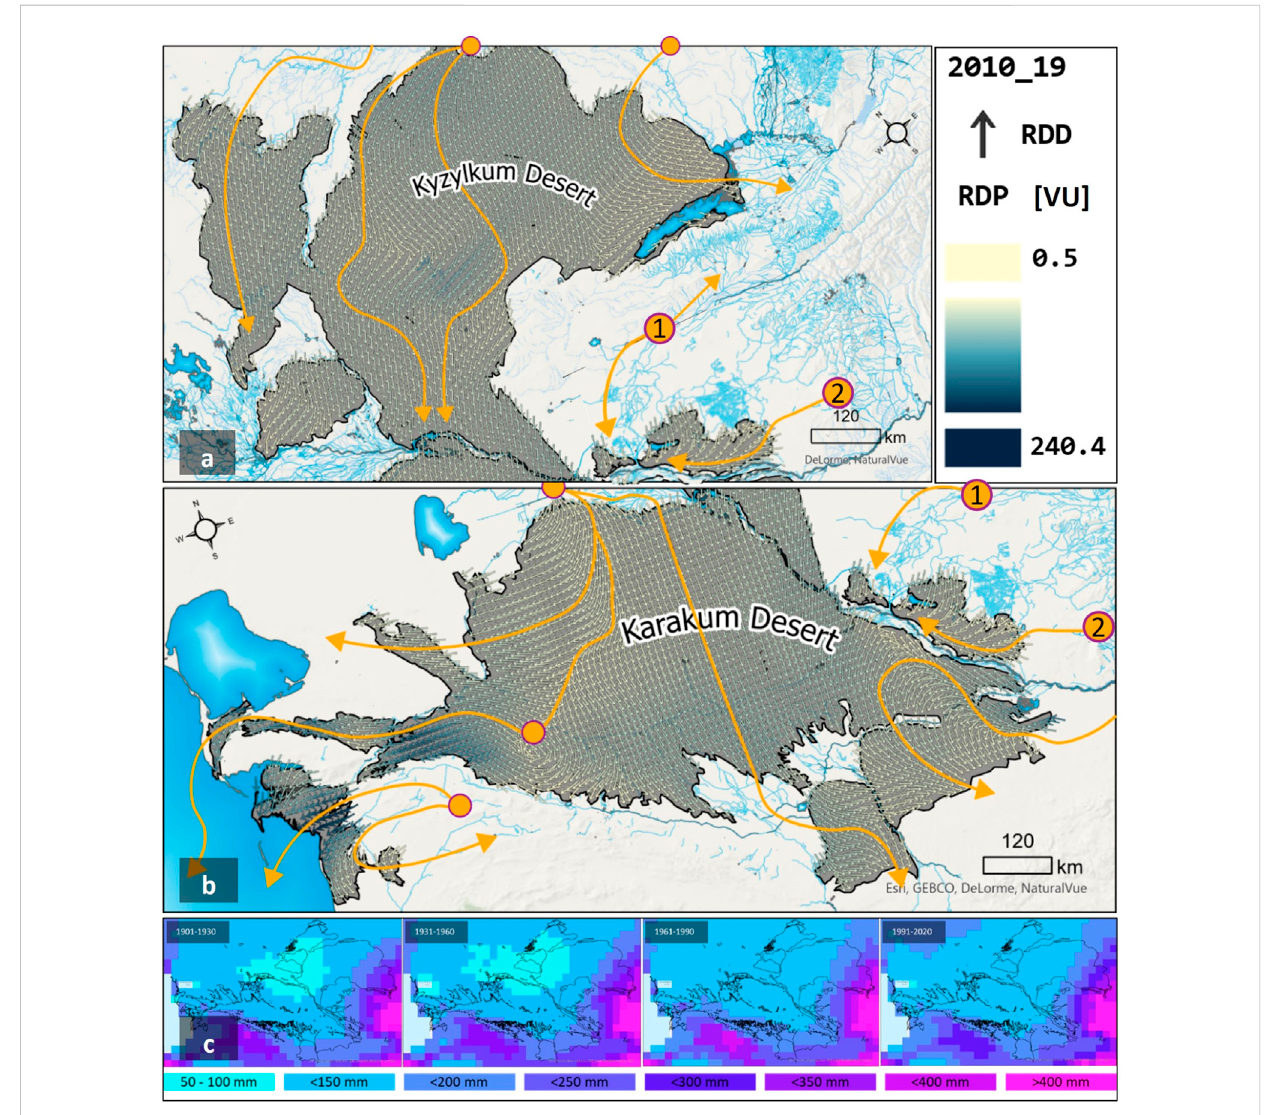
FIGURE 10 Sand roses resultant drift direction (RDD) for 5081 ERA5 grid control point over the Kyzylkum (inset a) and Karakum (inset b) Central Asian deserts (KKCAD), calculated for the statistical period 2010 – 2019. The color of theRDDvector represents theintensityof their powers, with amaximumreaching only 240.4 VU. The yellow arrows represent the manually inserted discernible wind drift trajectories, whereas the rings represent the signi fi cant intersections across the region, where erosive winds deviate from their primary routes. A four-climatic-precipitation-cycles composite (inset c), spanning from 1901 to 2020, emphasizes a suf fi cient amount of rainfall over the whole study